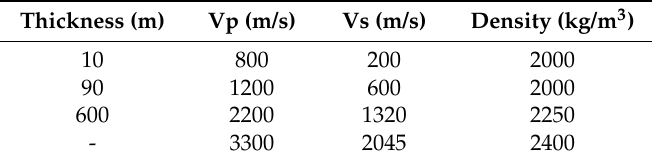
Table 4. The parameters of Model